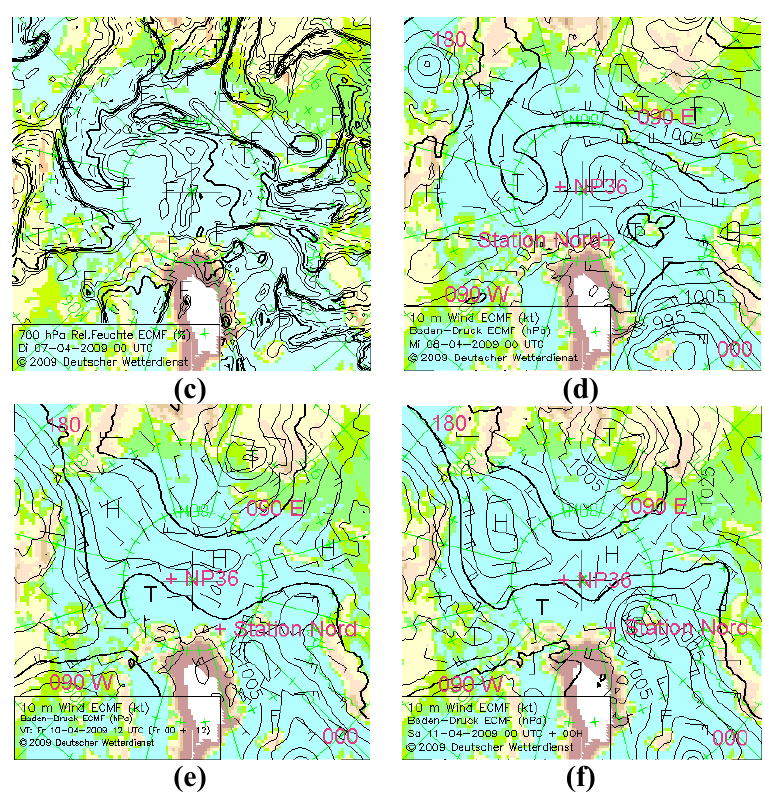
Figure 3. Photographs of the surface taken on board of the POLAR-5 on 5 April